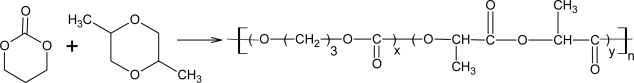
Synthesis of statistical poly(trimethylene carbonate-co-d,l-Lactide).